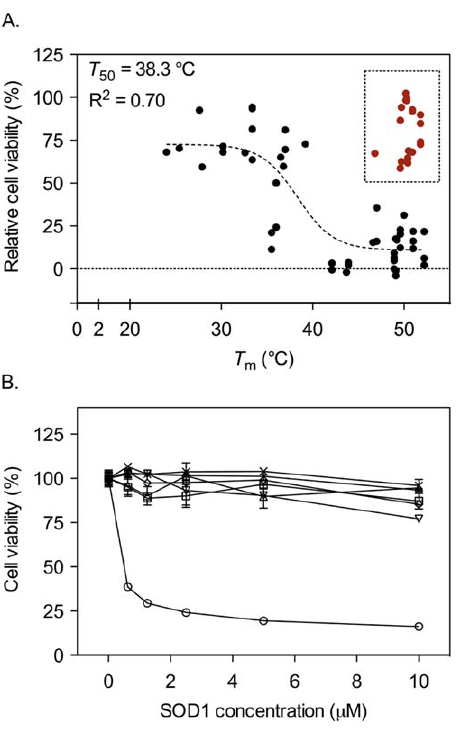
Figure 3. ApoSOD1 with perturbed Zn 2 + site is non-toxic. A set of apoSOD1 mutants with altered protein stability, charge and Zn 2 + binding capacity was added to SH-SY5Y cells in duplicate or triplicate in a concentration range of 0.6 to 10 m M and incubated for 72 h. Cell viability was measured with the MTT assay. ( A ) Relative cell viability was calculated as described in methods, and plotted as a function of melting temperature, T m (Eq.5, Table 1). A correlation between cell viability and protein stability is observed; overall, the viability is higher for SOD1 mutants with low T m . SOD1 variants with mutated Zn 2 + ligands as well as [F64A] and [D124G], all with a diminished ability to bind Zn 2 + , fall outside of this pattern (red symbols) (for detailed information, c.f. Table 1). The line represents a sigmoidal fit (Eq. 5) of all data points, except those from mutants with diminished ability to bind Zn 2 + . ( B ) Monomeric apoSOD1 ( # ) induces a toxic response, whereas [H63/71/80S;D83S] ( % ), [H71/80S;D83S] ( n ), [H71/80S] ( , ) and [H71S] ( e ) are all non-toxic. As all of these mutants lack H71, this amino acid was engineered back into [H63/71/80S;D83S] and [H71/80S;D83S], creating the mutants [H63/80S;D83S] ( 6 ) and [H80S;D83S] ( V ). However, these mutants show no effect on cell viability, indicating that it is the concerted action of the Zn 2 + ligands that underlies the toxicity, not H71 alone. Proteins were added in duplicate and data are presented as mean percentage of buffer control 6